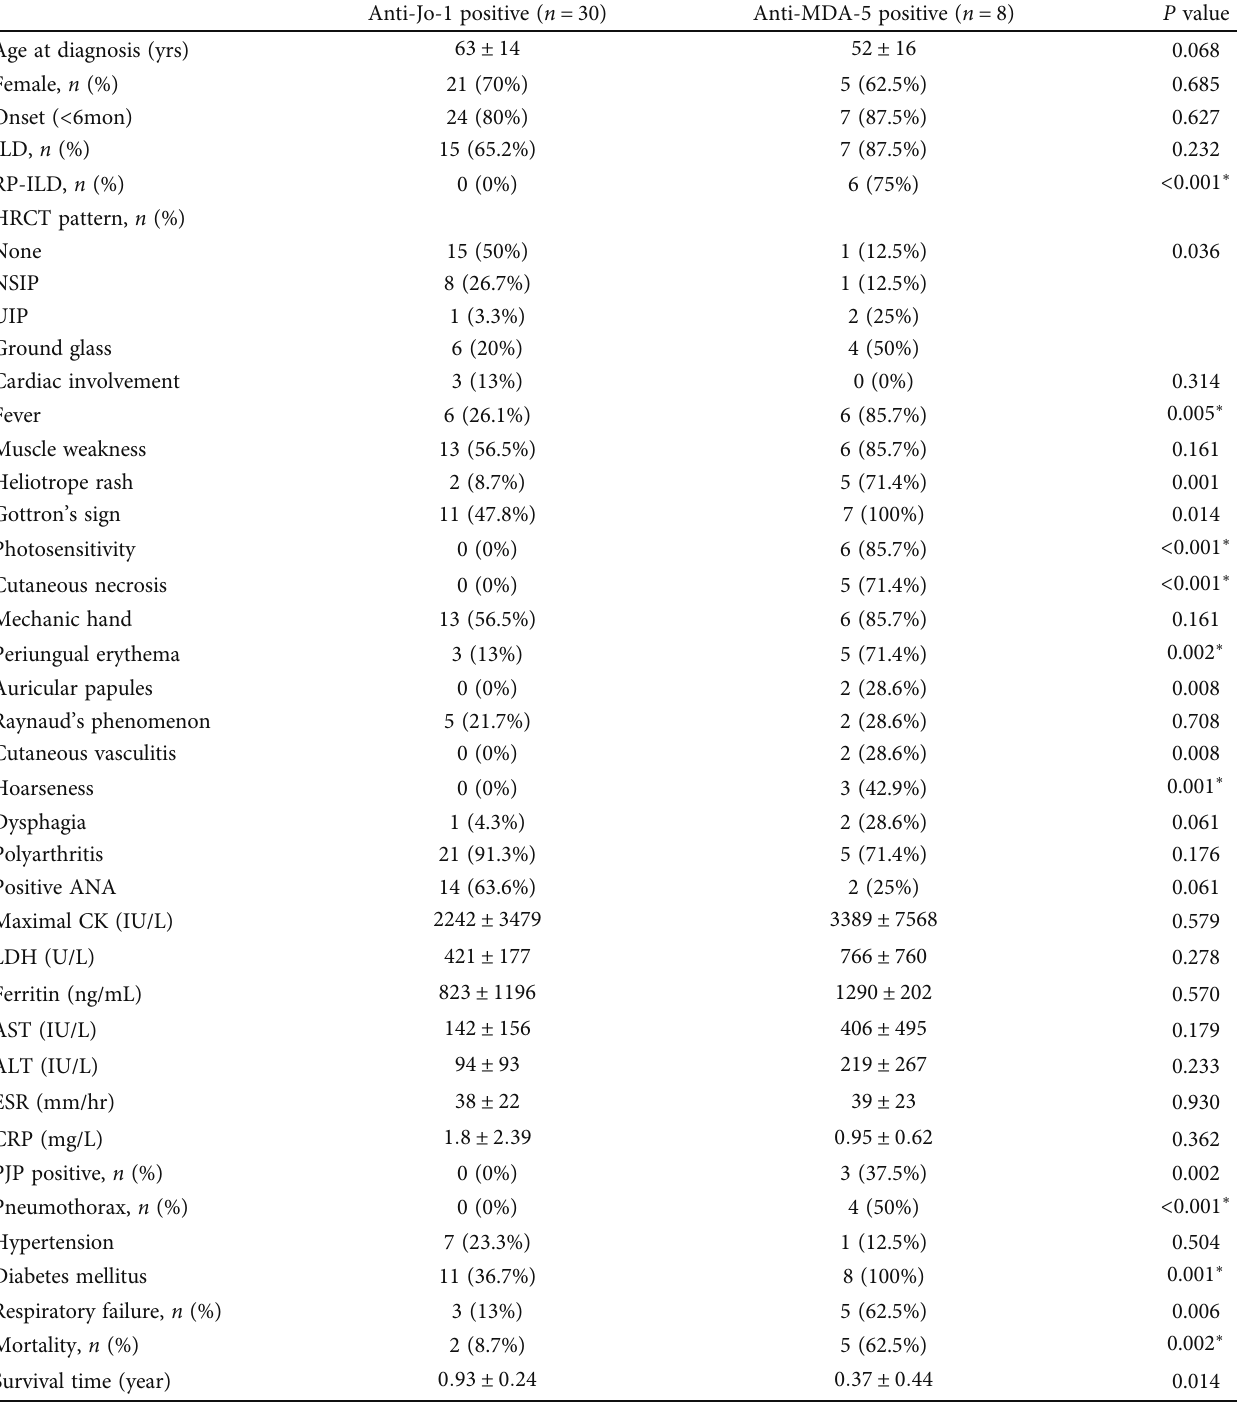
Table 1: Univariate analysis comparing the clinical characteristics of the anti-Jo-1 Abs and anti-MDA-5 Abs